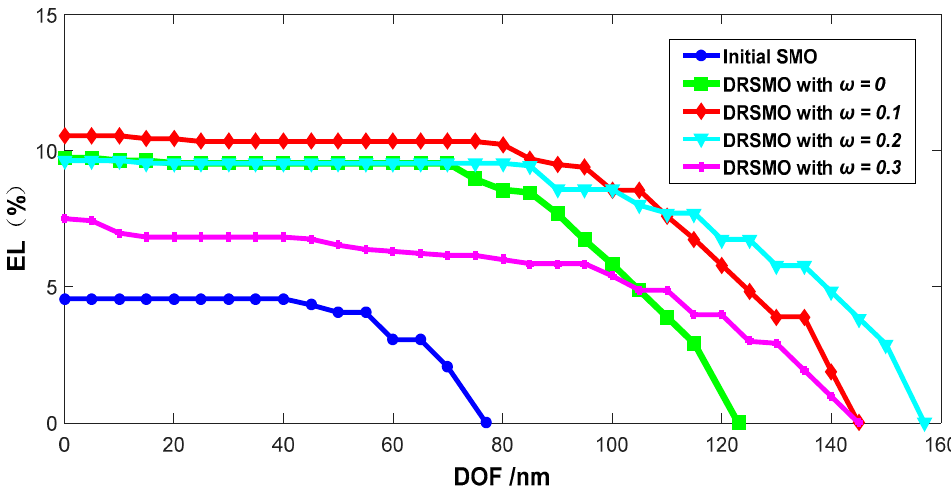
Figure 5. Process window (PW) of target 1 for the initial SMO (blue curve), the DRSMO with the weight factor ω = 0 (green curve), ω = 0.1 (red curve), ω = 0.2 (azury curve), and ω = 0.3 (purple curve). Optimizations were proceeded by the MBGD algorithm. Table 2. The target 1 optimized values of S β , depth of focus (DOF) (nm) corresponding to exposure latitude (El) equal to 5% and 8% for conventional SMO, and DRSMO with ω = 0, ω = 0.1, ω = 0.2, and ω = 0.3, respectively.